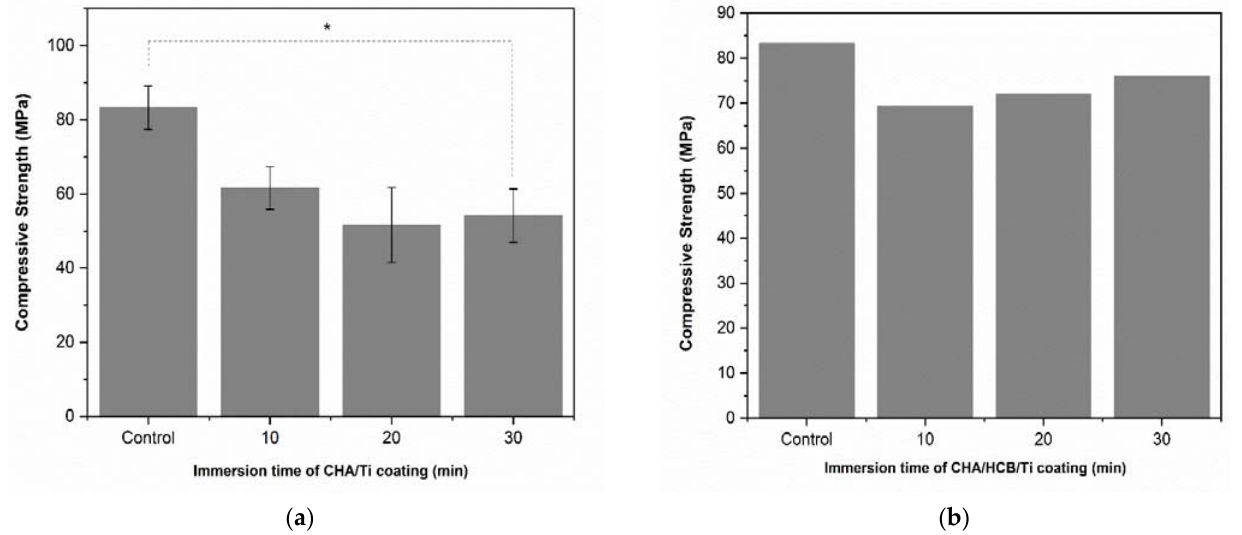
Figure 6. Average compressive strength values of: ( a ) CHA/Ti coating (*: p > 0.05); ( b ) CHA/HCB/Ti. Table 4. Average compressive strength of CHA/Ti coating.